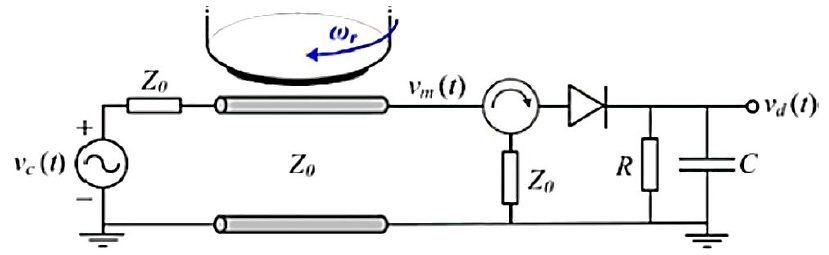
Figure 15. Sketch of the system for the measurement of angular velocities based on an AM modulation scheme.